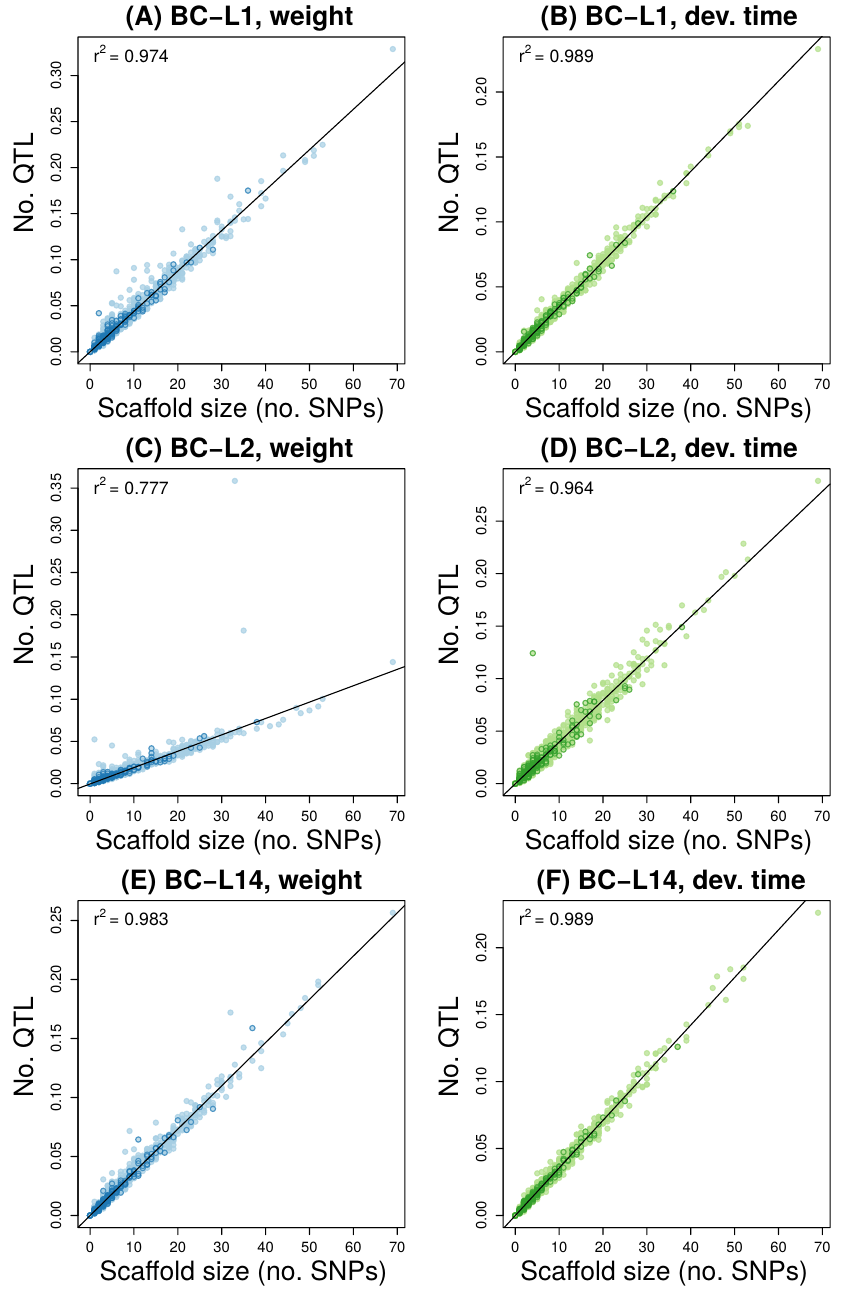
Figure 4. The scatter plots depict Bayesian estimates for the number of QTL (i.e., causal variants) on each scaffold as a function of scaffold size (here measured as the number of SNPs). Results are shown for each back-cross line (BC-L1, BC-L2 and BC-L14) and trait (weight [A, C, and E] and development time [B, D, and F]). Points representing X-linked scaffolds are denoted with dark outlines. A best fit line from linear regression is given and the coefficient of determination ( r 2 ) is reported. Points that fall well-above the best fit line harbor more QTL than expected given their size and a highly polygenic architecture of very small effect variants scattered evenly across the